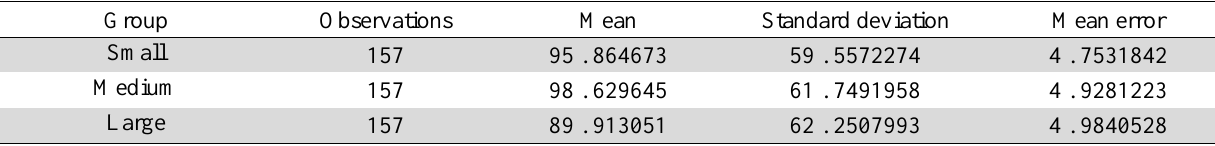
The summary of some statistics associated with small/medium and large firms Group